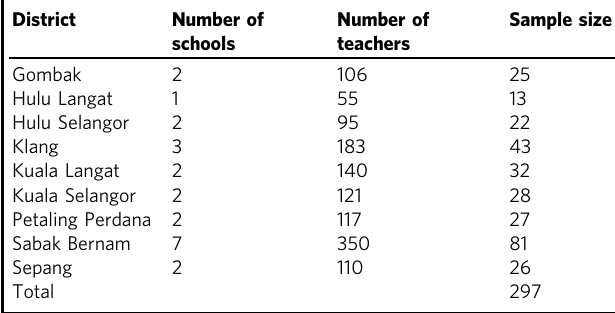
Table 1 Distribution of GFRS in